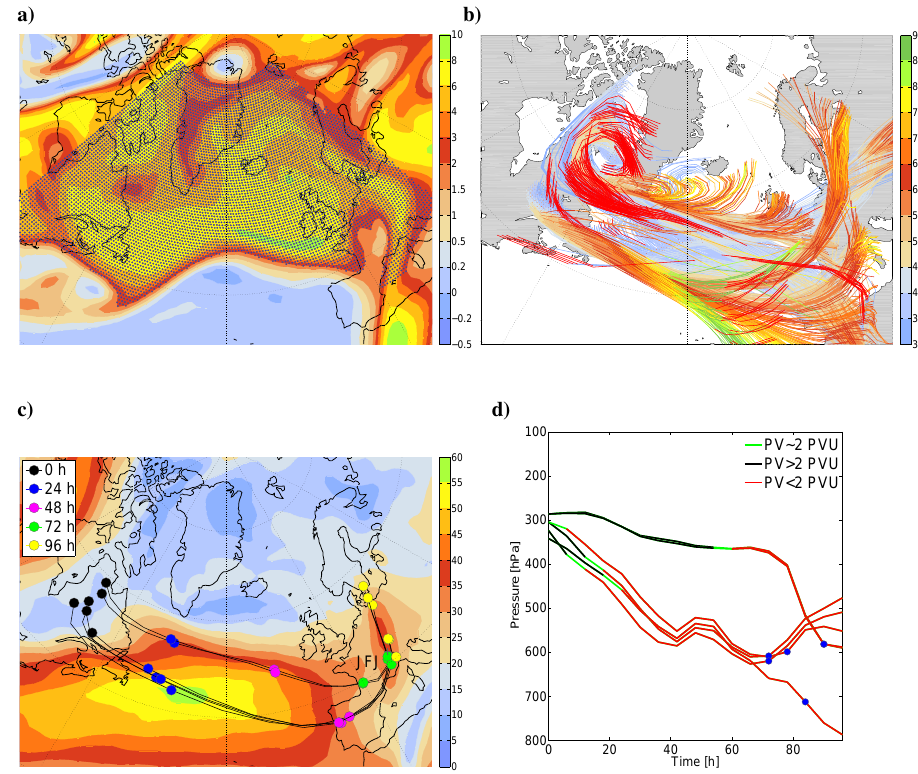
Figure 4. Example of a stratosphere–troposphere exchange (STE) forecast based on LAGRANTO trajectories. (a) Equidistant (50km hori- zontal spacing) starting positions at 250hPa in the stratosphere (PV > 2PVU) and in color PV at 00:00UTC on 18 January 2009; (b) selection of 96h forward trajectories that descend more than 300hPa and start above 400hPa (colored according to pressure); (c) refined selection of descending trajectories that pass the Jungfraujoch (JFJ) measurement site within 100km horizontal distance. The color shading gives the averaged wind speed at 400hPa during the 4 days and the dots mark the position of the air parcels at the given times; (d) vertical evolution of JFJ trajectories shown in panel (c) , colored according to their PV value. The dots mark the time and pressure when geographically the air parcel is closest to the